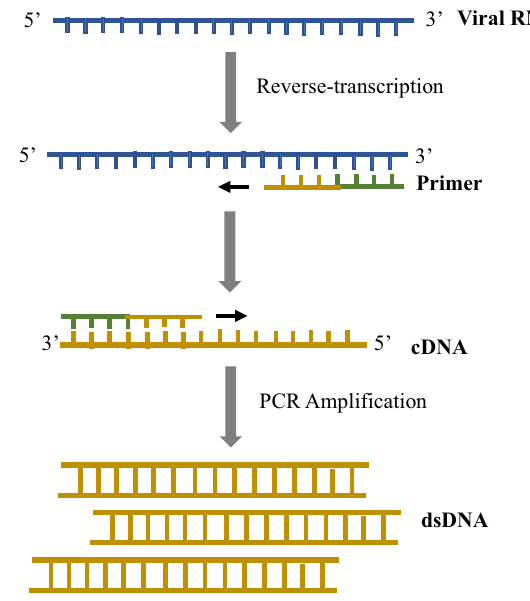
Fig. 1 Schematic illustration of RT-PCR. Before RT-PCR is performed, the sample obtained from a tested individual is subsequently subjected to a lysis reaction and RNA purification to extract the viral RNA. If the targeted viral RNA is present, the specific primer binds to a complementary region of the RNA, and reverse transcriptase generates the first-strand complementary DNA (cDNA) using the viral RNA template. Then, PCR cycle at different temperatures to separate the DNA strands (including the first-strand cDNA) allows binding of DNA primers to the template DNA and then allows DNA polymerase enzyme to extend the new DNA strand. Ultimately, this creates more copies of the double-stranded DNA (dsDNA) that allow detection of the viral nucleotide. Adapted from Xu et al .